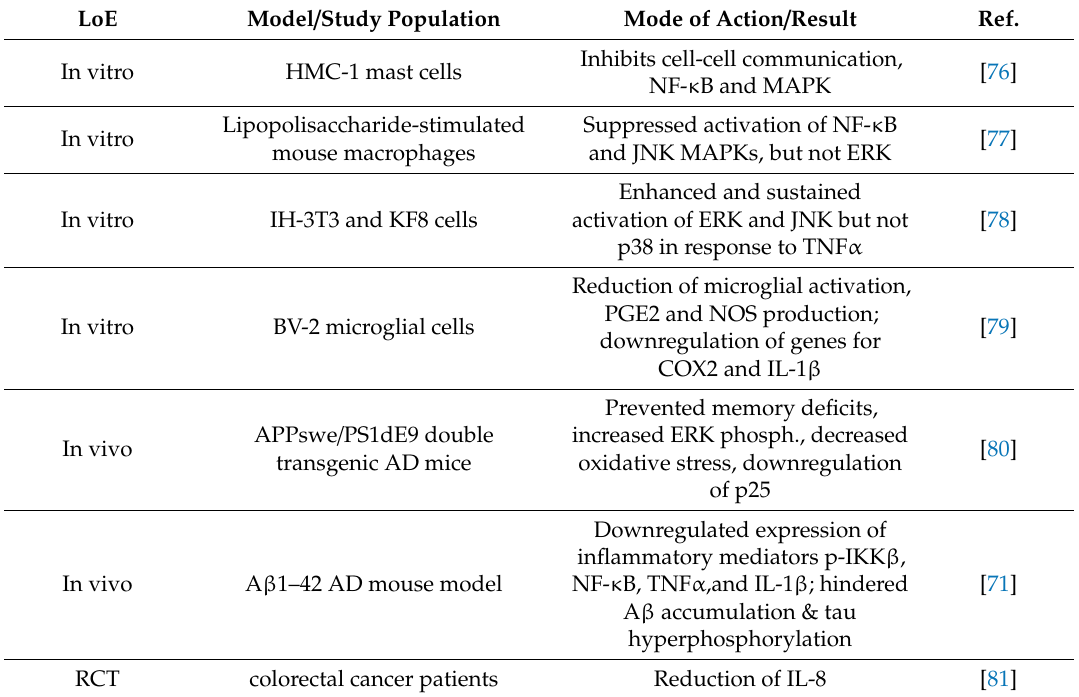
Table 2. Anti-inflammatory e ff ects of fisetin in various